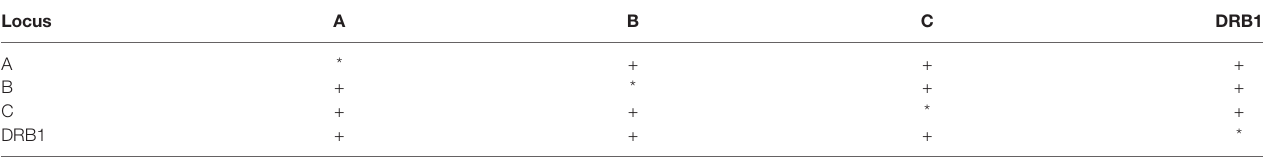
TABLE 4 | Linkage disequilibrium for all pairs ofthe four loci (+: signi fi cance level = 0.0500). Locus A B C DRB1 A * + + + B + * + + C + + * + DRB1 + + + * (Linkage disequilibrium test for the four loci [HLA-A, -B, -C, and -DRB1 correspond with 0, 1, 2, and 3): Pair(0,1) LnLHood LD: − 33501.32038; LnLHood LE: − 38575.47508; Exact P = 0.00000 ± 0.00000; Chi-square test value = 10148.30939 (P = 0.00000, 3588 d.f.); Pair(0,2) LnLHood LD: − 29520.02695, LnLHood LE: − 33505.12195; Exact P = 0.00000 ± 0.00000; Chi-square test value = 7970.18999 (P = 0.00000, 1794 d.f.); Pair(1,2) LnLHood LD: − 25562.82326; LnLHood LE: − 38684.15862; Exact P = 0.00000 ± 0.00000, Chi-square test value = 26242.67073 (P = 0.00000, 4232 d.f.); Pair(0,3) LnLHood LD: − 31686.72178, LnLHood LE: − 34053.13059; Exact P = 0.00000 ± 0.00000, Chi-square test value = 4732.81762 (P = 0.00000, 2379 d.f.); Pair(1,3) LnLHood LD: − 33568.25664; LnLHood LE: − 39232.16727; Exact P = 0.00000 ± 0.00000, Chi-square test value = 11327.82126 (P = 0.00000, 5612 d.f.); Pair(2,3) LnLHood LD: − 30180.47304; LnLHood LE: − 34161.81414;